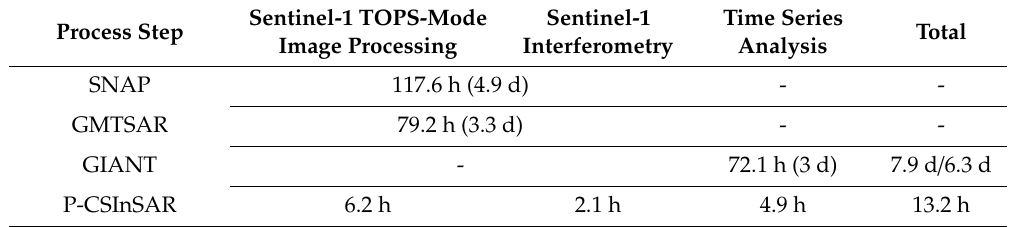
Table 1. Processing time for Scene 142-2 with di ff erent software packages (h: Hour, d: